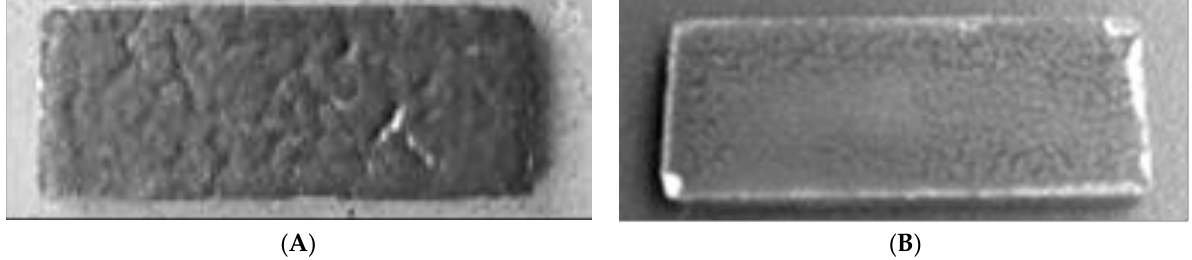
Figure 11. Macrographics of sintered and enameled samples in one step at 835 °C and different times: ( A ) 30 min and ( B ) 5 min.